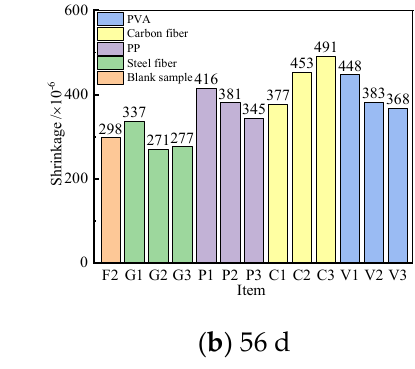
Figure 12. Shrinkage curves of the UHPC cured for 7 d and 56 d.